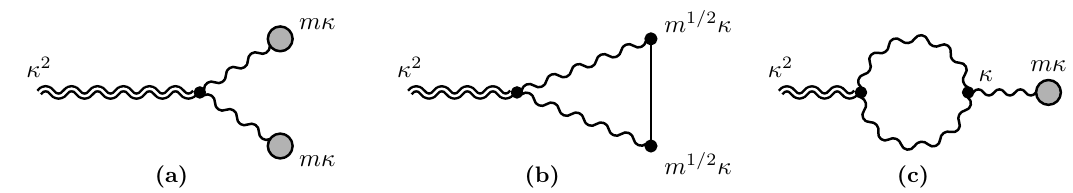
Figure 4. Contributions to hH µν ( x ) i arising from the field-dependent coordinates. The explicit form of X in (2.10) gives rise to the X -graviton-graviton interaction vertex, with the source (2) (2) term J denoted by a double wiggly line since it contains two gravitons. The possible combinations (2) with the other interaction vertices result in the depicted